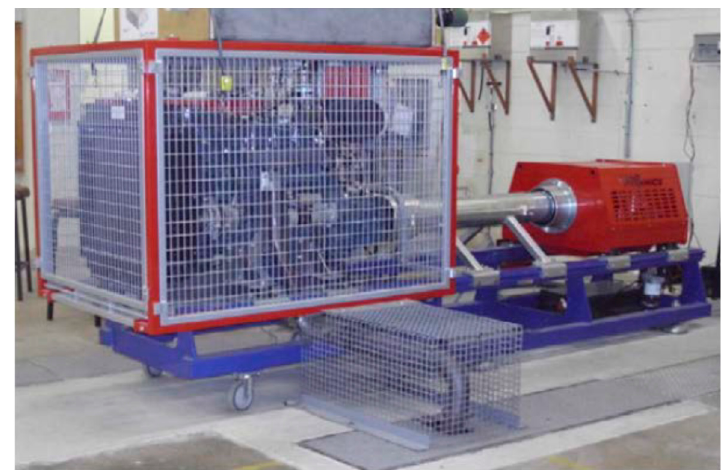
Figure 2. Engine test bed used in this study. Energies 2016 , 9 , 402